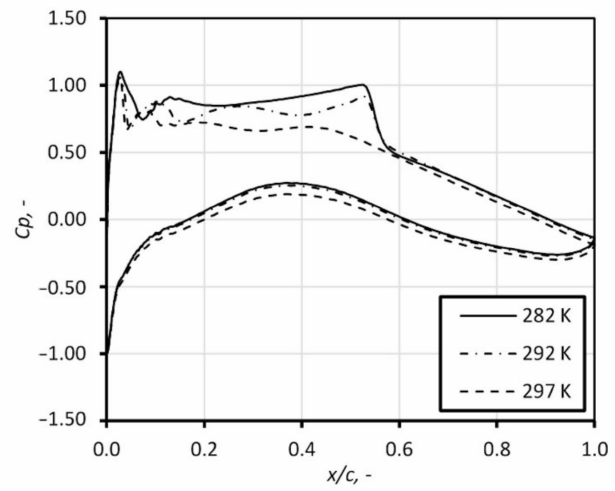
Figure 13. Influence of the inlet total temperature on pressure coe ffi cient distribution on the airfoil for humid air with relative humidity of 70%.